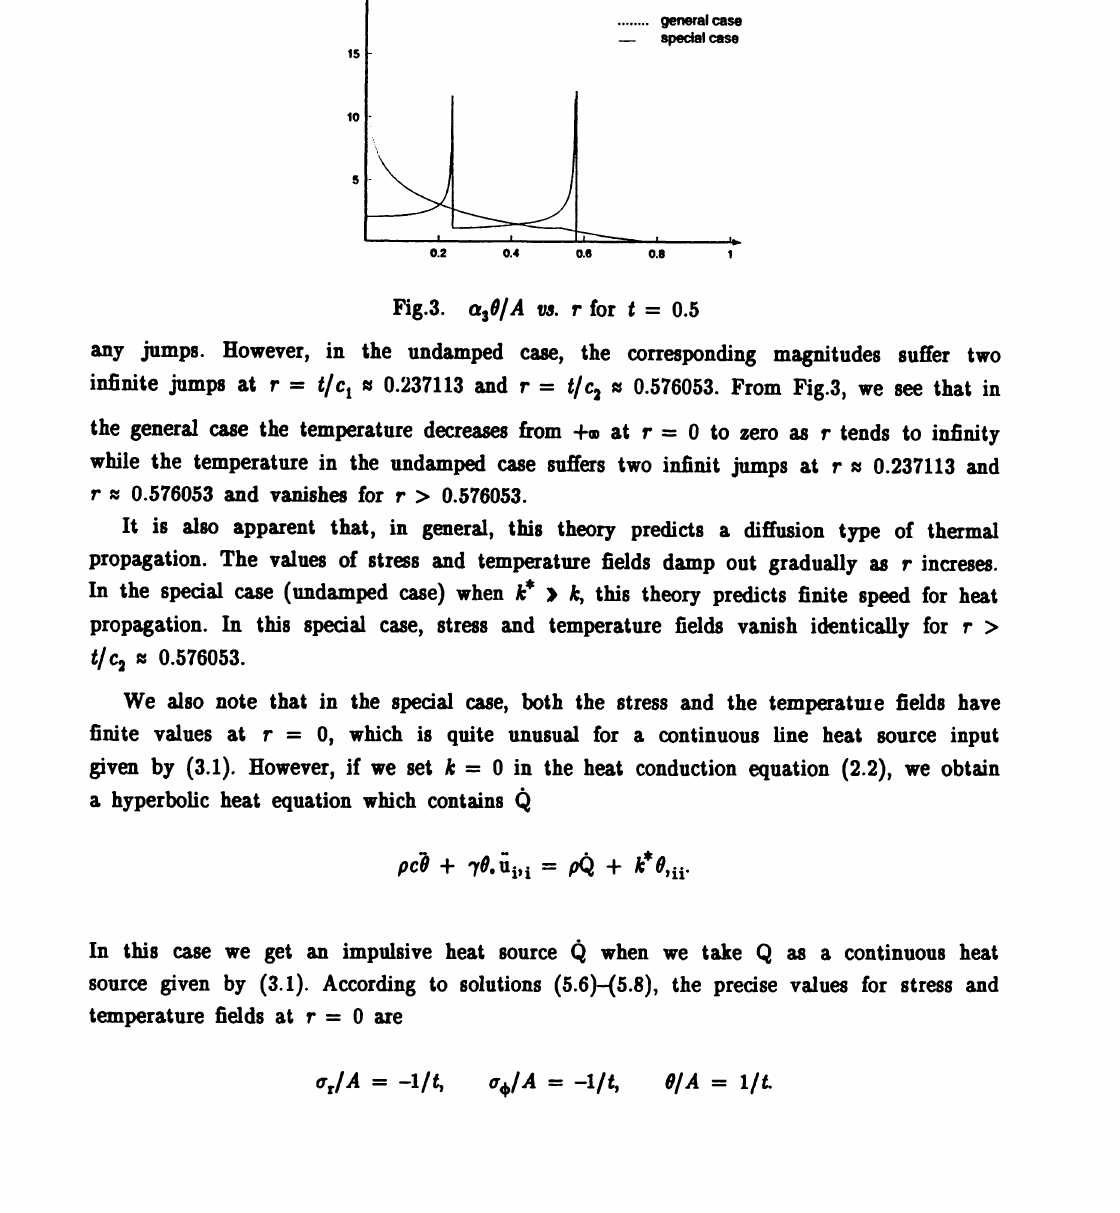
Or/A es. r for 0. Fig.2. <r/A vs. r for 0.5 Fig.1.